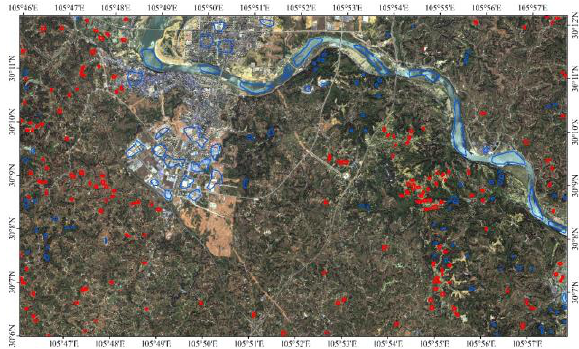
Figure 5. The selected sample areas. (The red map spot is the cultivated land sample area, and the blue map spot is the sample area of other ground features.)